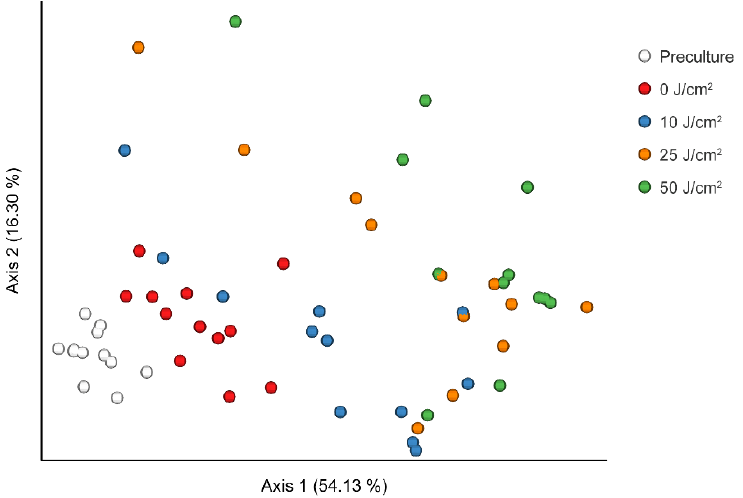
Figure 4. Principal coordinate analysis of weighted Unifrac distances between samples ( p = 0.001, pairwise permutational analysis of variance).